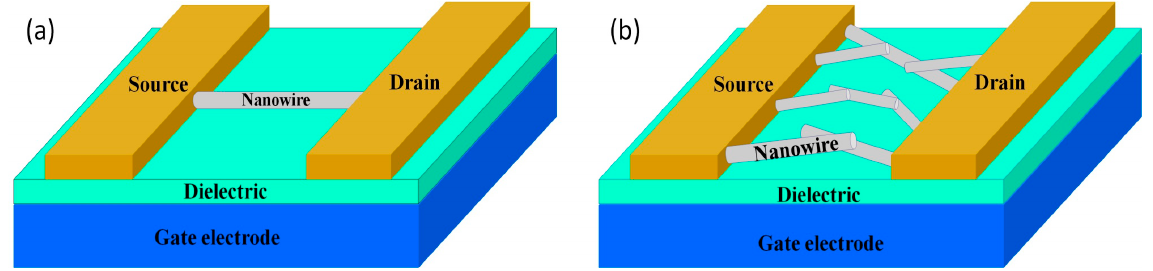
Figure 1. Schematic drawing of nanowire FET gas sensors. ( a ) Individual nanowire as the channel. ( b ) Nanowire network film as the